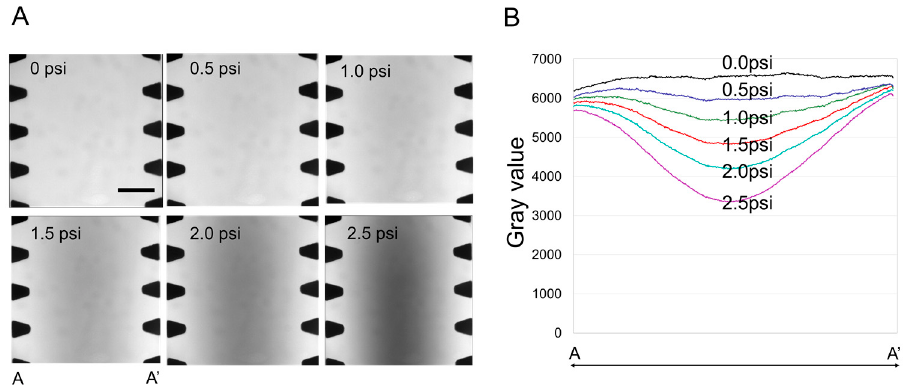
Figure 2. The pixel intensity of the transverse direction in the central channel and PDMS membrane finite element analysis. ( A ) The change of gray value by the membrane deflection at six different pressures. The central channel was filled with FITC-dextran solution. Scale bar: 100 µ m. ( B ) Gray value plot of the central channel.